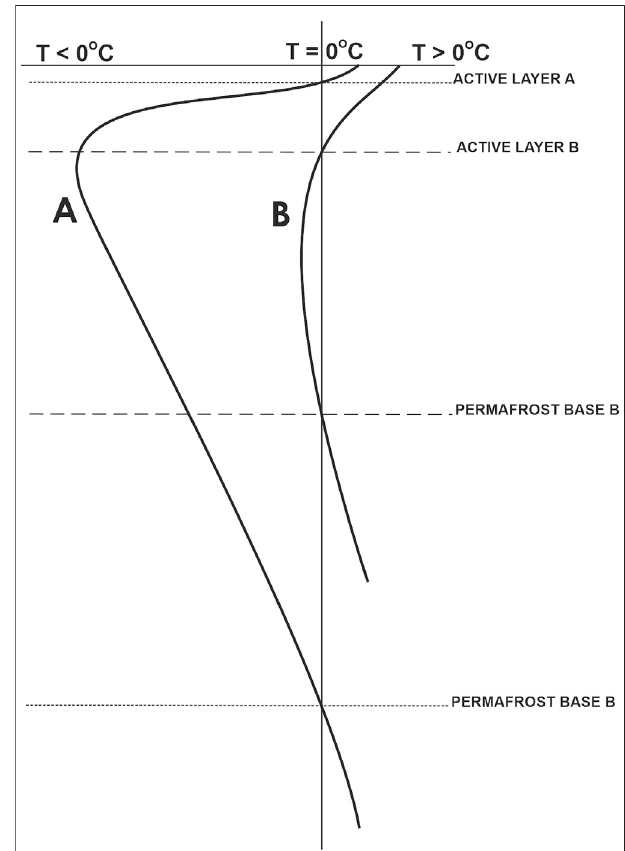
FIGURE 3 | General shape of degrading permafrost pro fi le thermal curve. Notes: (A) — initial stage, cold permafrost (boomerang-like shape), (B) — degrading permafrost (bow-like shape). Compare the difference between the amount of degradation of the top (AL) and the bottom of